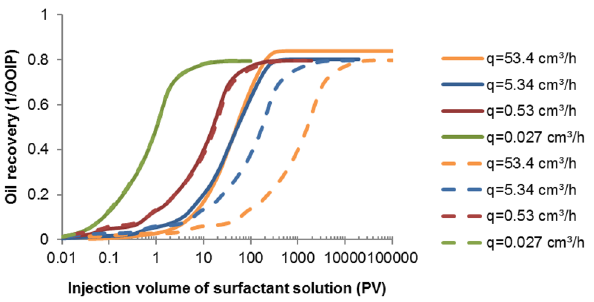
Fig. 19 Oil recovery of surfactant flooding following a pre-water flooding with in the contrastive case (without surfactant diffusion)